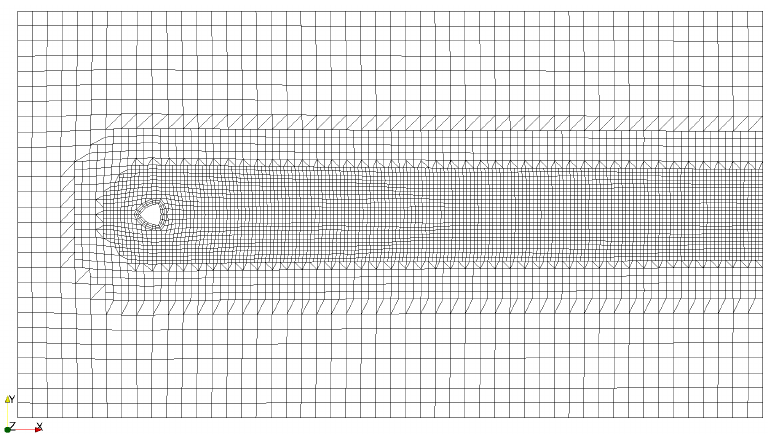
Figure 5. An example of the mesh with reuleaux shape snapped off of the